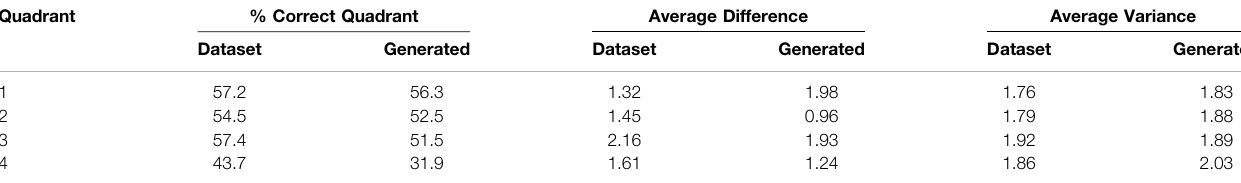
TABLE 1 | Results of emotion survey for dataset phrases compared with generated phrases. See Generation Evaluation for an explanation of the metrics. Quadrant